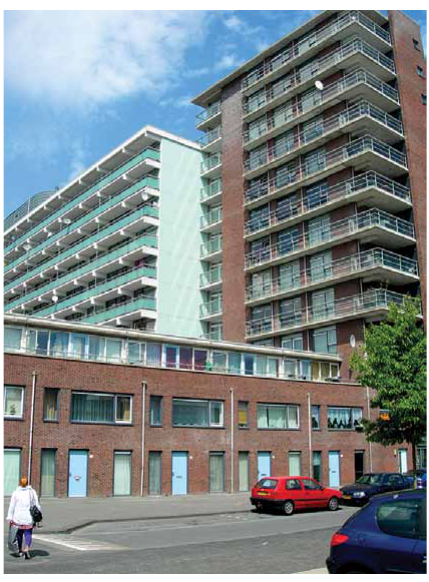
fig. 8. Bijlmermeer estate in amsterdam Note: after partial demolition of most declined blocks new housing typologies are introduced in the neighborhood. original housing typology (apartments in a block) and new typology (apartments in the row houses) create diversity and stimulate social